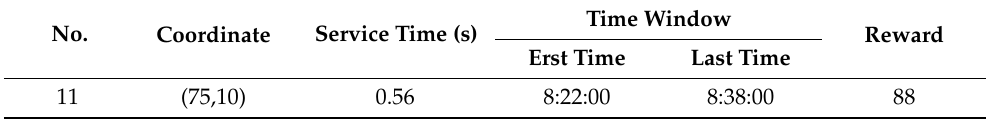
Table 9. Parameter of the Emergency Tasks.